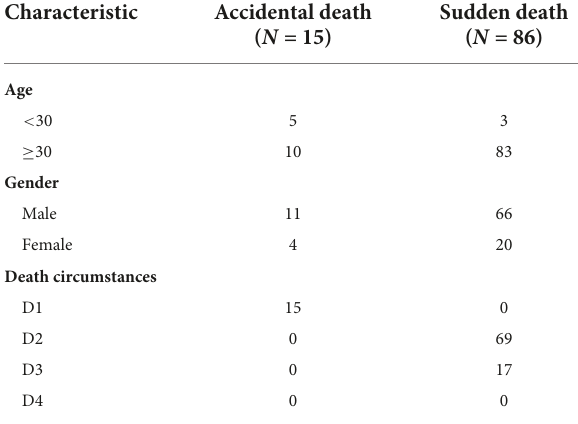
TABLE 1 Summary of clinical information for